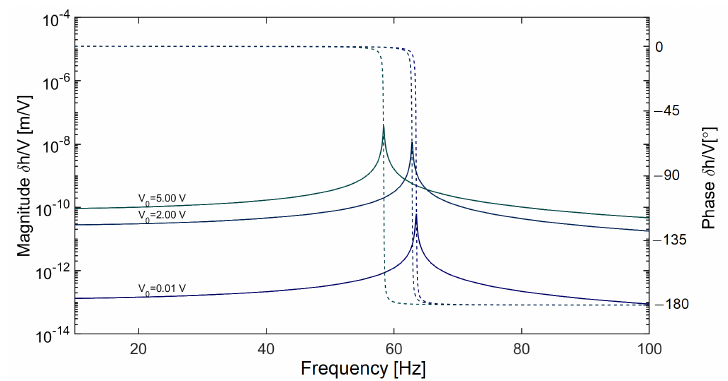
Figure 4. Frequency characteristics of the sensor’s mechanical response to a small perturbation in electrostatic bias, showing a considerable frequency shift of the resonance peak and a rise in sensitivity to the perturbation with rising electrostatic bias voltage. This shift is approximately quadratic. Solid curves indicate magnitude and dashed curves indicate